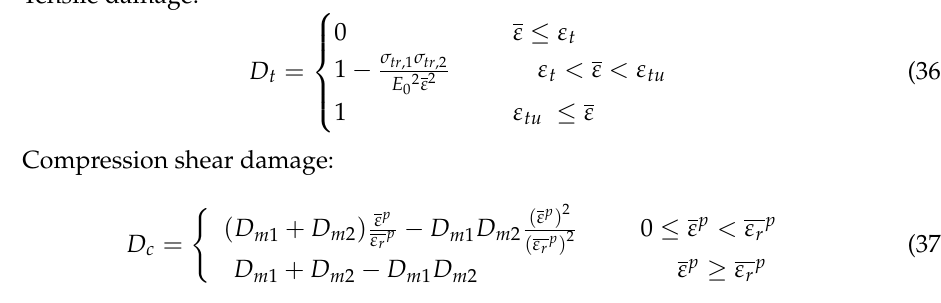
damage variable, ( b ) shear damage